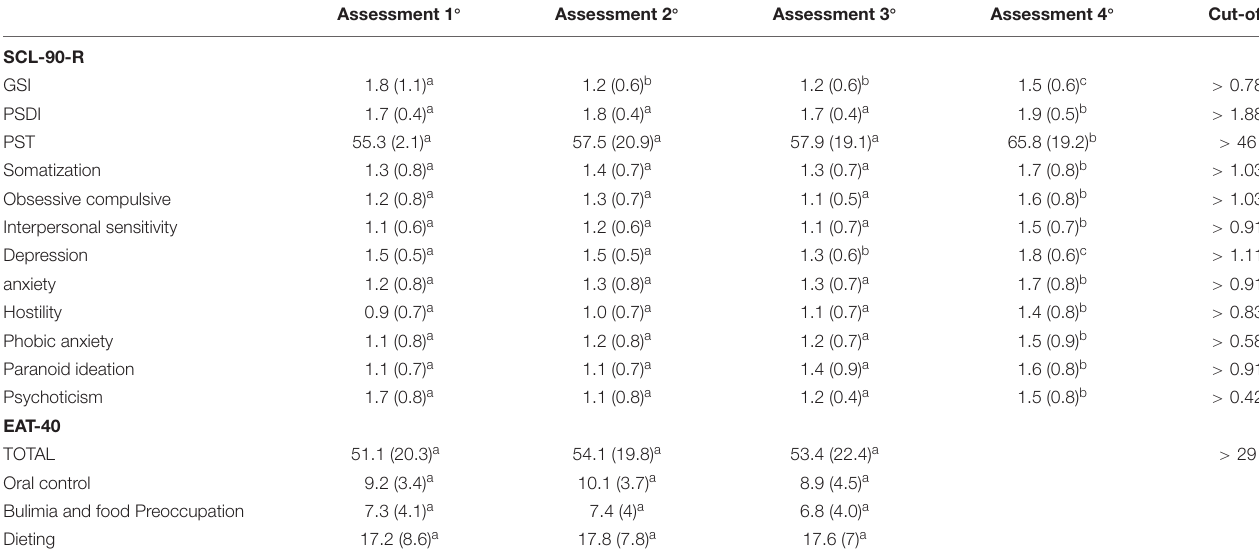
TABLE 5 | Means (SD) of the SCL-90 and of the EAT-40 scores by group and time of